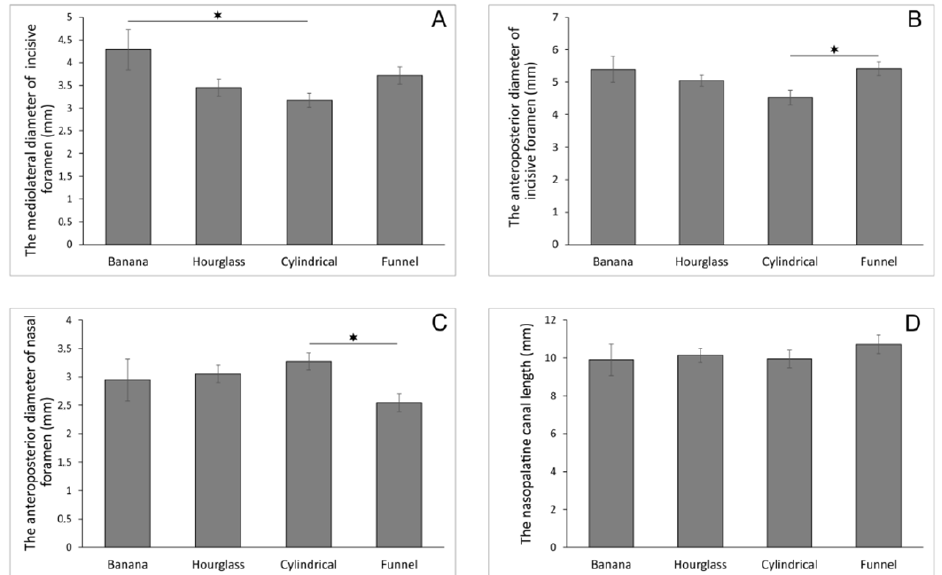
Figure 2. The diameters of the nasopalatine canal according to the nasopalatine canal shape in sagittal cross-section (in mm). ( A ) the mediolateral diameter of incisive foramen; ( B ) the anteroposterior diameter of incisive formane; ( C ) the anteroposterior diameter of nasal foramen; ( D ) the nasopalatine canal length. Values are expressed as the mean ± SEM. * Denotes a significant difference, p < 0.05.